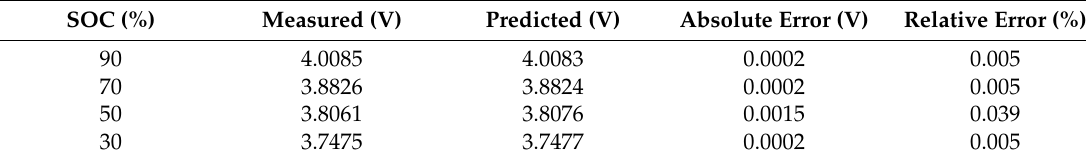
Figure 5. The measured and fitted voltage relaxation results of LCO/MCMB battery (Cell-1) at different SOC points: (a) 90%, (b) 70%, (c) 50%, and (d) 30%. It was discharged with 0.25 C at 35 °C.